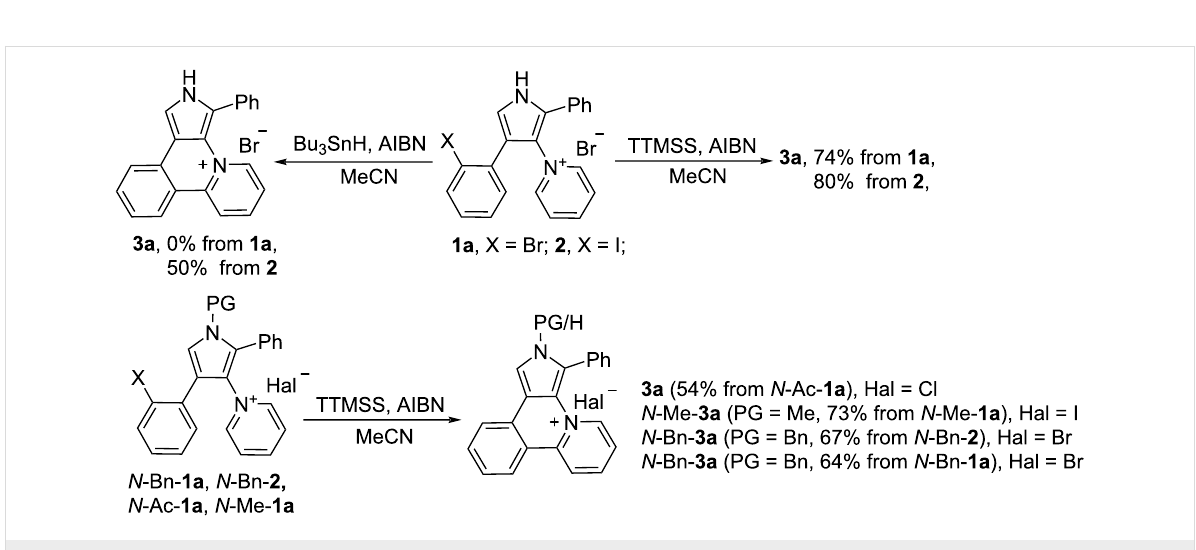
Scheme 2: Free-radical cyclization of N -protected and N -unprotected pyrroles 1a and 2